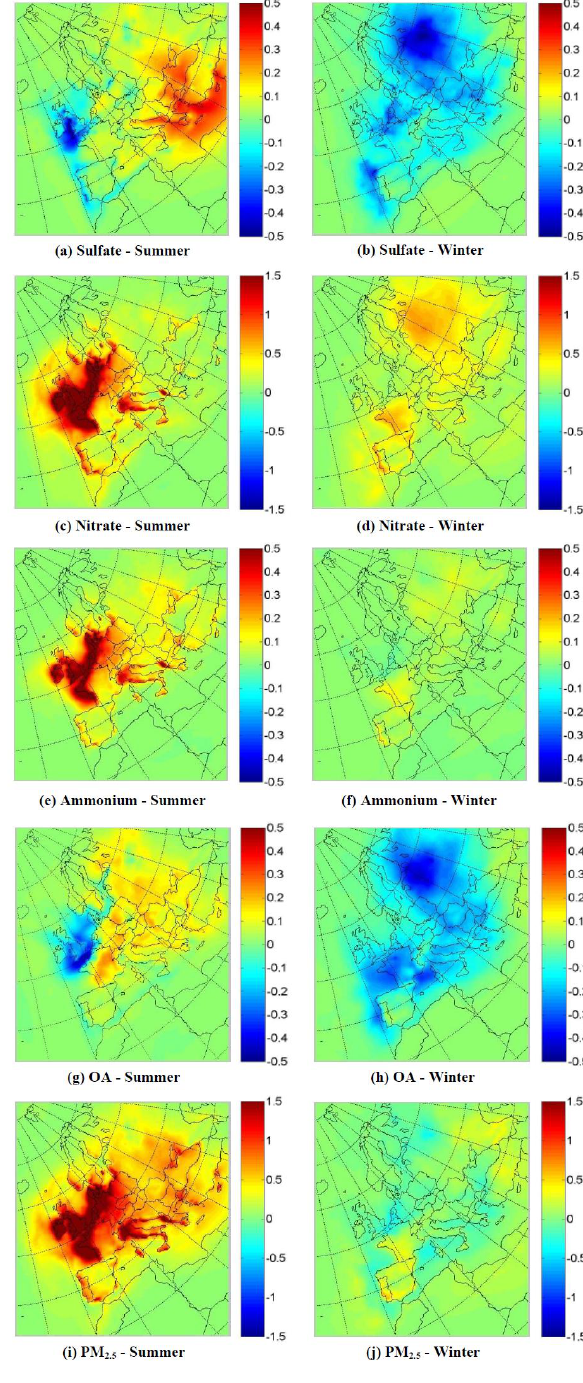
Fig. 4. Predicted reduction (base case – emissions reduction sce- Figure 4. Predicted reduction (base case - emissions reduction scenario) in ground-level 3 nario) in ground-level concentrations (µgm − 3 ) of (a–b) sulfate, (c– concentrations (μg m -3 ) of (a-b) sulfate, (c-d) nitrate, (e-f) ammonium, (g-h) total OA, and (i-4 d) nitrate, (e–f) ammonium, (g–h) total OA, and (i–j) total PM 2 . 5 j) total PM 2.5 after a 50% reduction of NO x emissions during the modeled summer and the 5 after a 50% reduction of NO x emissions during the modeled sum- modeled winter period. A positive value corresponds to a decrease. 6 mer and the modeled winter period. A positive value corresponds to a